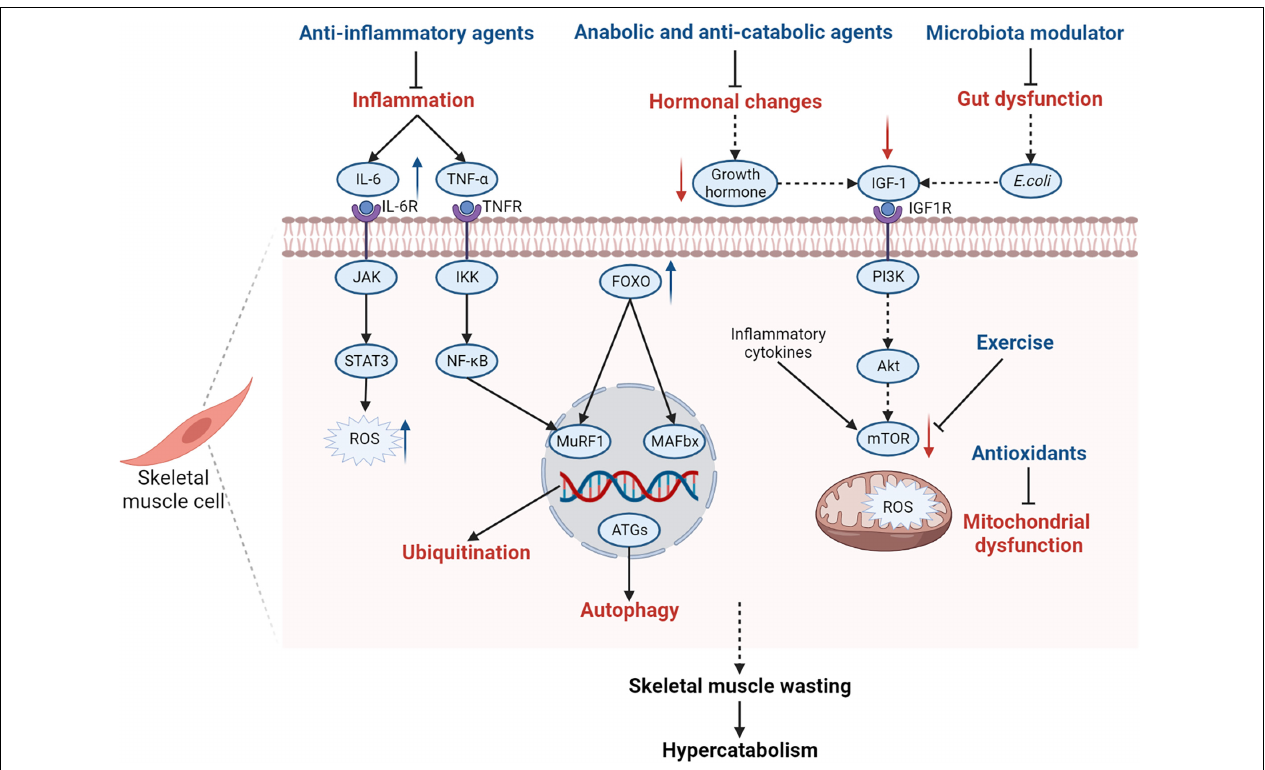
FIGURE 4 | Summary of pathophysiological mechanisms of skeletal muscle wasting in PICS and related therapies. Many pathophysiological changes in PICS affect the function of skeletal muscle cells and contribute to skeletal muscle wasting in patients with PICS. Inflammatory cytokines, such as IL-6 and TNF- α , induce protein degradation by activating the gp130/JAK/STAT3 and IKK/IKB/NF- κ B signaling pathways, contributing to the production of ROS in muscle cells. Elevated inflammatory cytokines also inhibit the mTOR-mediated signaling pathway to decrease protein synthesis. Some hormones such as growth hormones are inhibited during PICS, which will cause decreased IGF-1 levels and suppress the IGF-1/PI3K/Akt/mTOR signaling pathway. Alterations in Escherichia coli , as a part of gut dysfunction, also lead to the suppression of the IGF-1/PI3K/Akt/mTOR signaling pathway by inhibiting IGF-1 production. Hence, exercise and IGF-1 supplementation are encouraged for patients with PICS to activate the mTOR signaling pathway and promote protein synthesis. In addition, the expression of FOXO is upregulated in skeletal muscle cells, which can increase the activity of MAFbx and MuRF1, activating the ubiquitin-proteasome system as a result. The autophagy-lysosome system is also activated and the levels of autophagy-related genes are upregulated. Mitochondrial dysfunction contributes to the increase in ROS, which induces skeletal muscle wasting and hypercatabolism in PICS. Therefore, anti-inflammatory agents, anabolic and anti-catabolic agents, microbiota modulators, and antioxidants are recommended for patients with PICS. IL-6, interleukin 6; IL-6R, interleukin 6 receptor; JAK, Janus kinase; STAT3, signal transducer and activator of transcription 3; ROS, reactive oxygen species; TNF- α , tumor necrosis factor α ; TNFR, tumor necrosis factor receptor; IKK, I κ B kinase